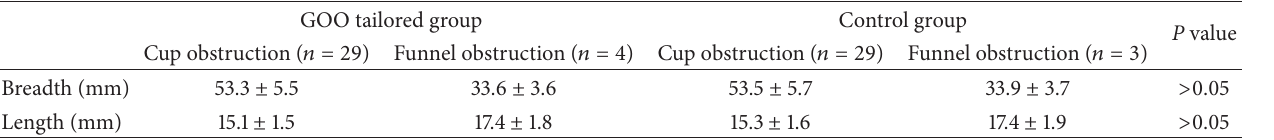
Table 1: Numbers of cases and obstruction dimensions.